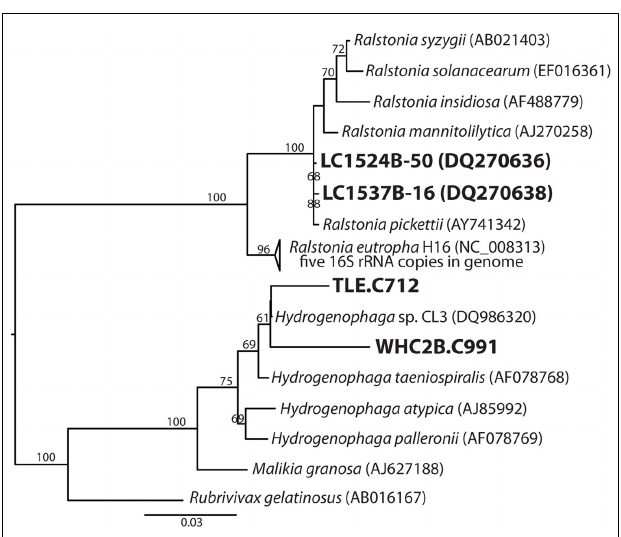
FIGURE 2 |Taxonomic assignment of contigs (plotted with respect to length and %GC) assembled fromWHC2b metagenomic sequences. Large Burkholderiales contigs with high %GC (yellow triangles) dominate the